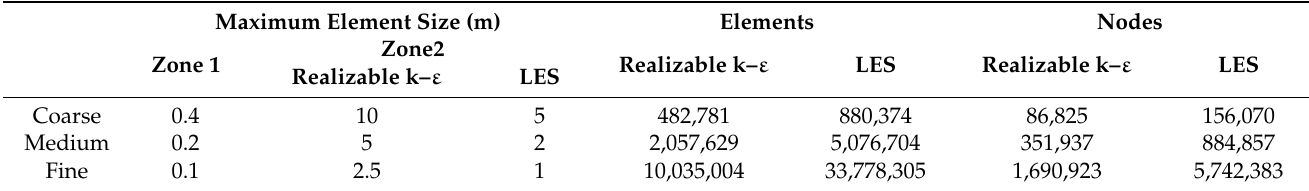
Table A1. Meshing schemes in the sensitivity